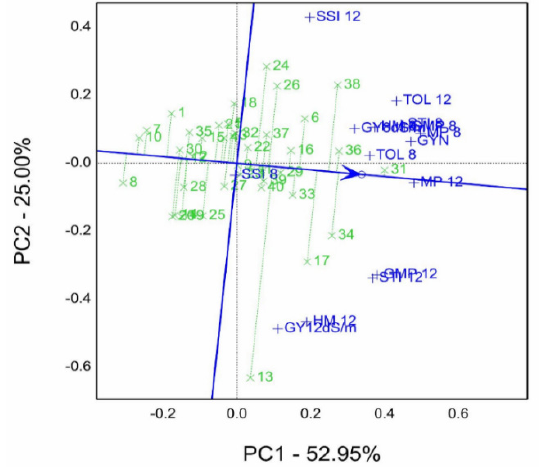
Figure 7. Mean vs. stability (GSTI) biplot of ranking genotypes based on grain yield gm per pot (GYN), grain yield gm per pot (GY 8.0, 12.0 dS/m), and salinity tolerance/susceptible indices (calculated at control with 0.4 dS/m, 8.0 dS/m, and 12.0 dS/m) of forty genotypes in the 2019/20 season. TOL, tolerance index; MP, mean productivity; STI, stress tolerance index; GMP geometric mean productivity; HM, harmonic mean; SSI, stress susceptibility index.